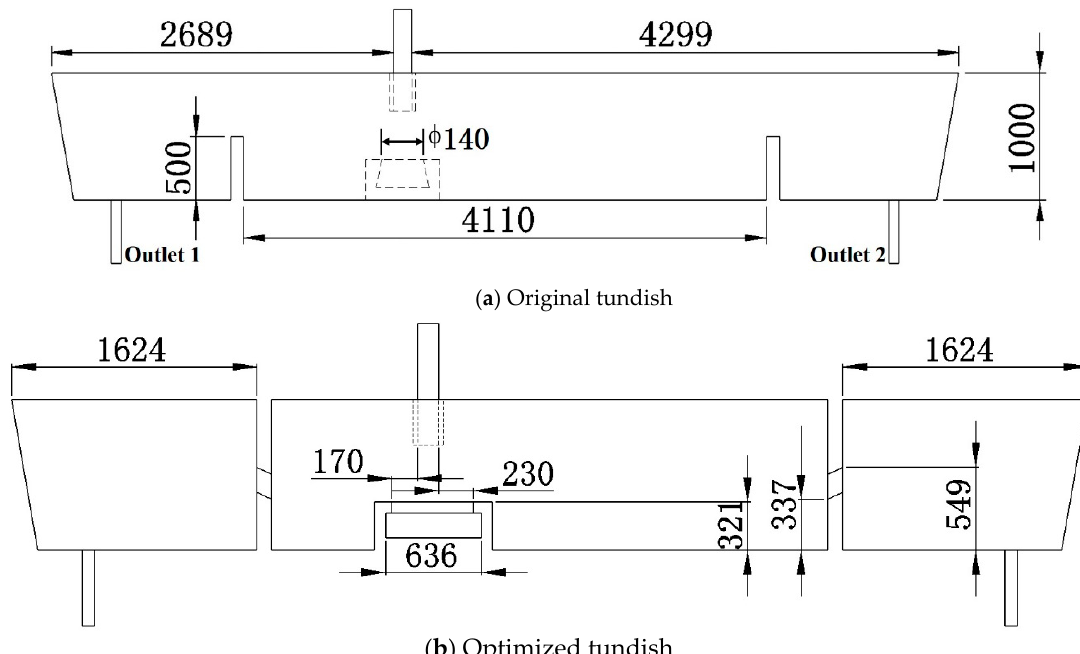
Figure 2. Tundish structure (all dimensions are in mm). Table 1. Parameters in the model tundish.